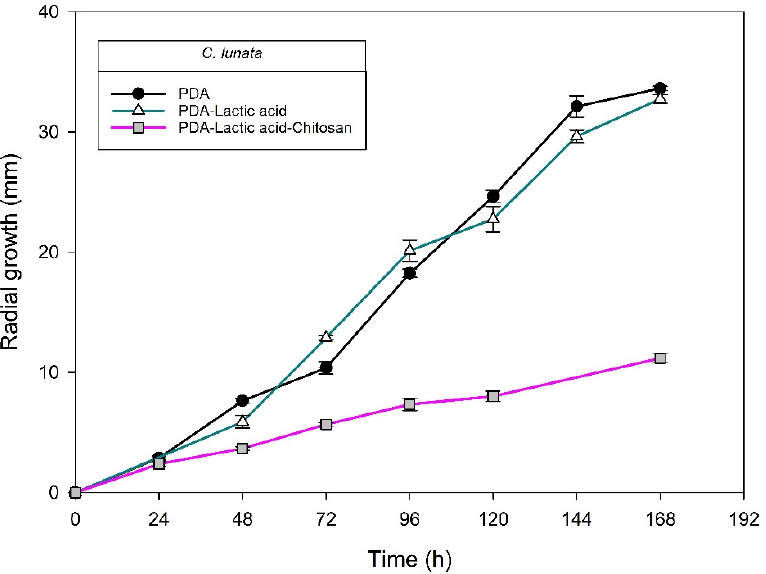
Figure 11. Curvularia lunata isolated from anthracnose of mango. Kinetics of radial growth (mm) in medium PDA, PDA-lactic acid (0.05 M), and PDA-lactic acid (0.05 M) with 1 g L − 1 chitosan at 25 °C.